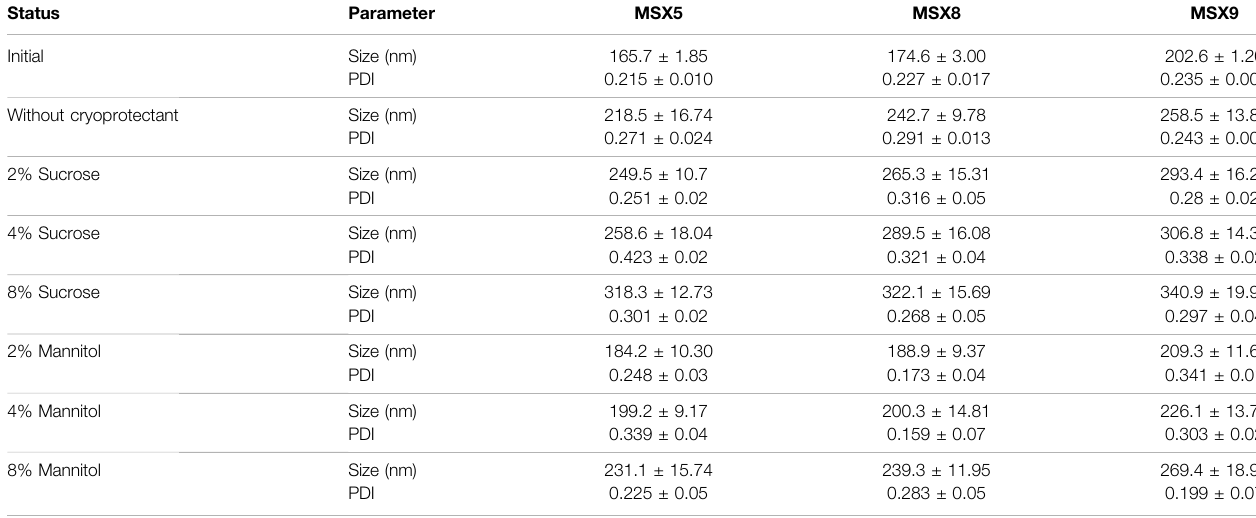
TABLE 7 | The impact of Freeze drying on methotrexate nano-formulations with different cryoprotectant (Mannitol and sucrose).